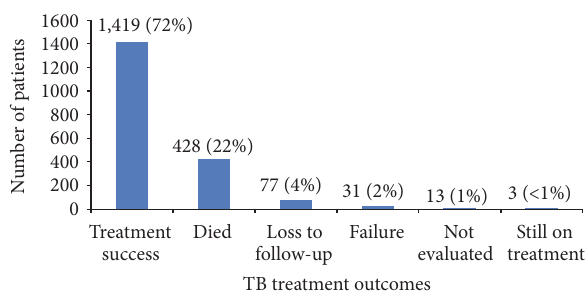
Figure 1: Overall TB treatment outcomes among enrolled patient on TB treatment in southern Zimbabwe, 2013. TB =